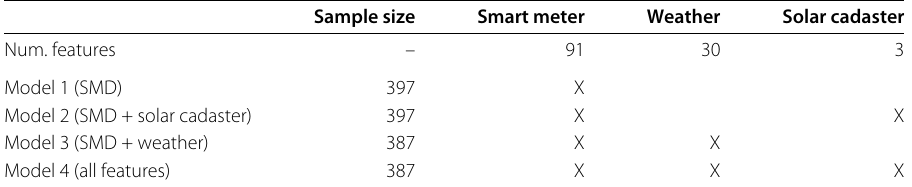
Table 2 Tested combinations of feature sets and available entries in the dataset for heat pump existence Sample size Smart meter Weather Solar cadaster Num.